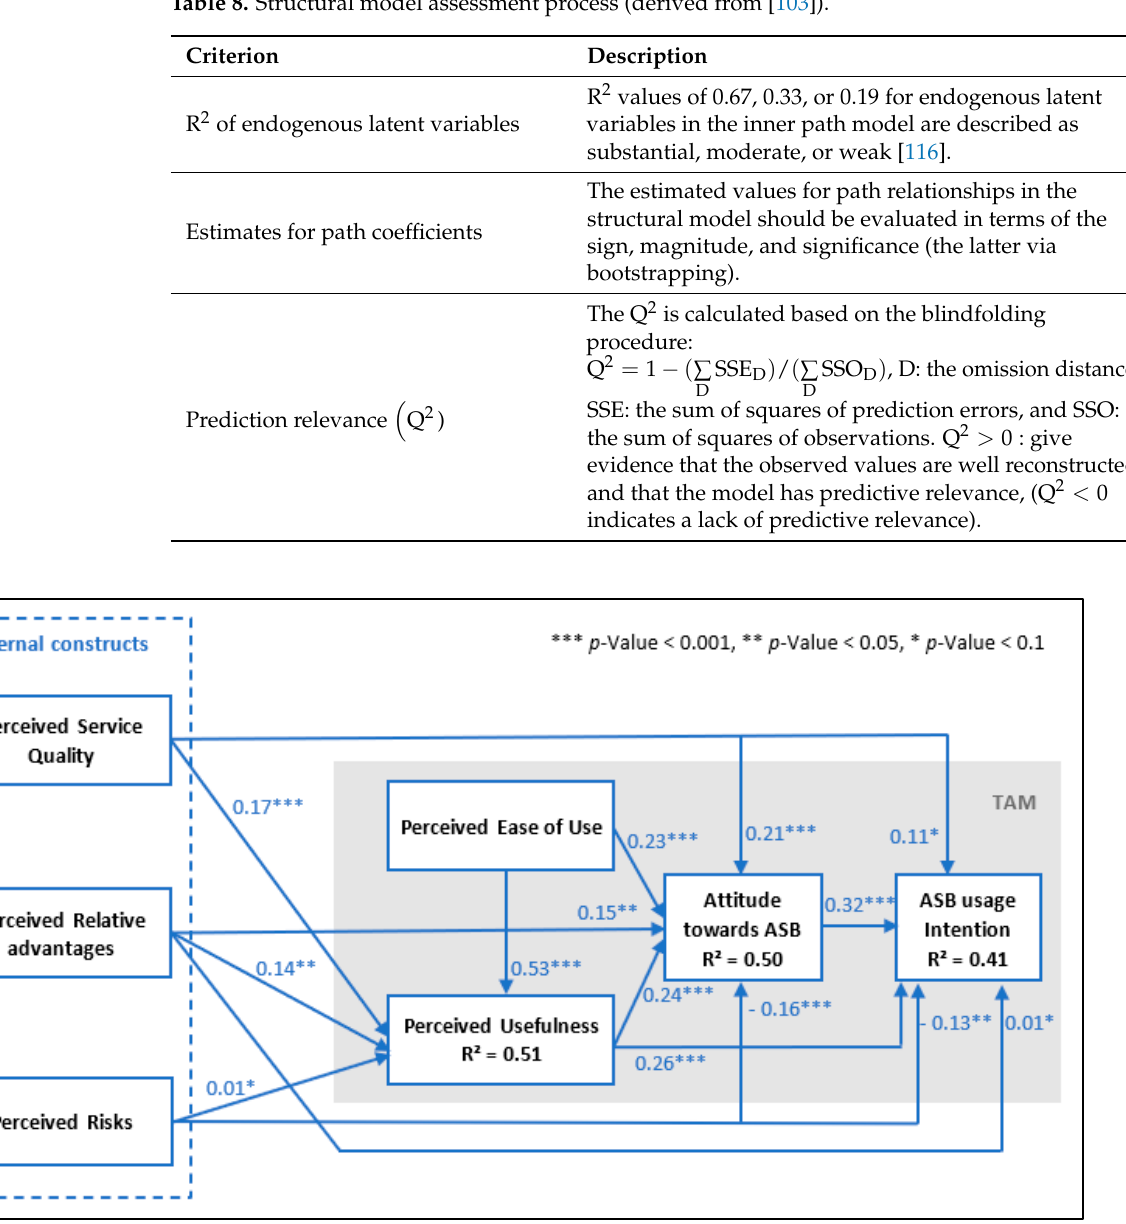
Figure 3. Structural